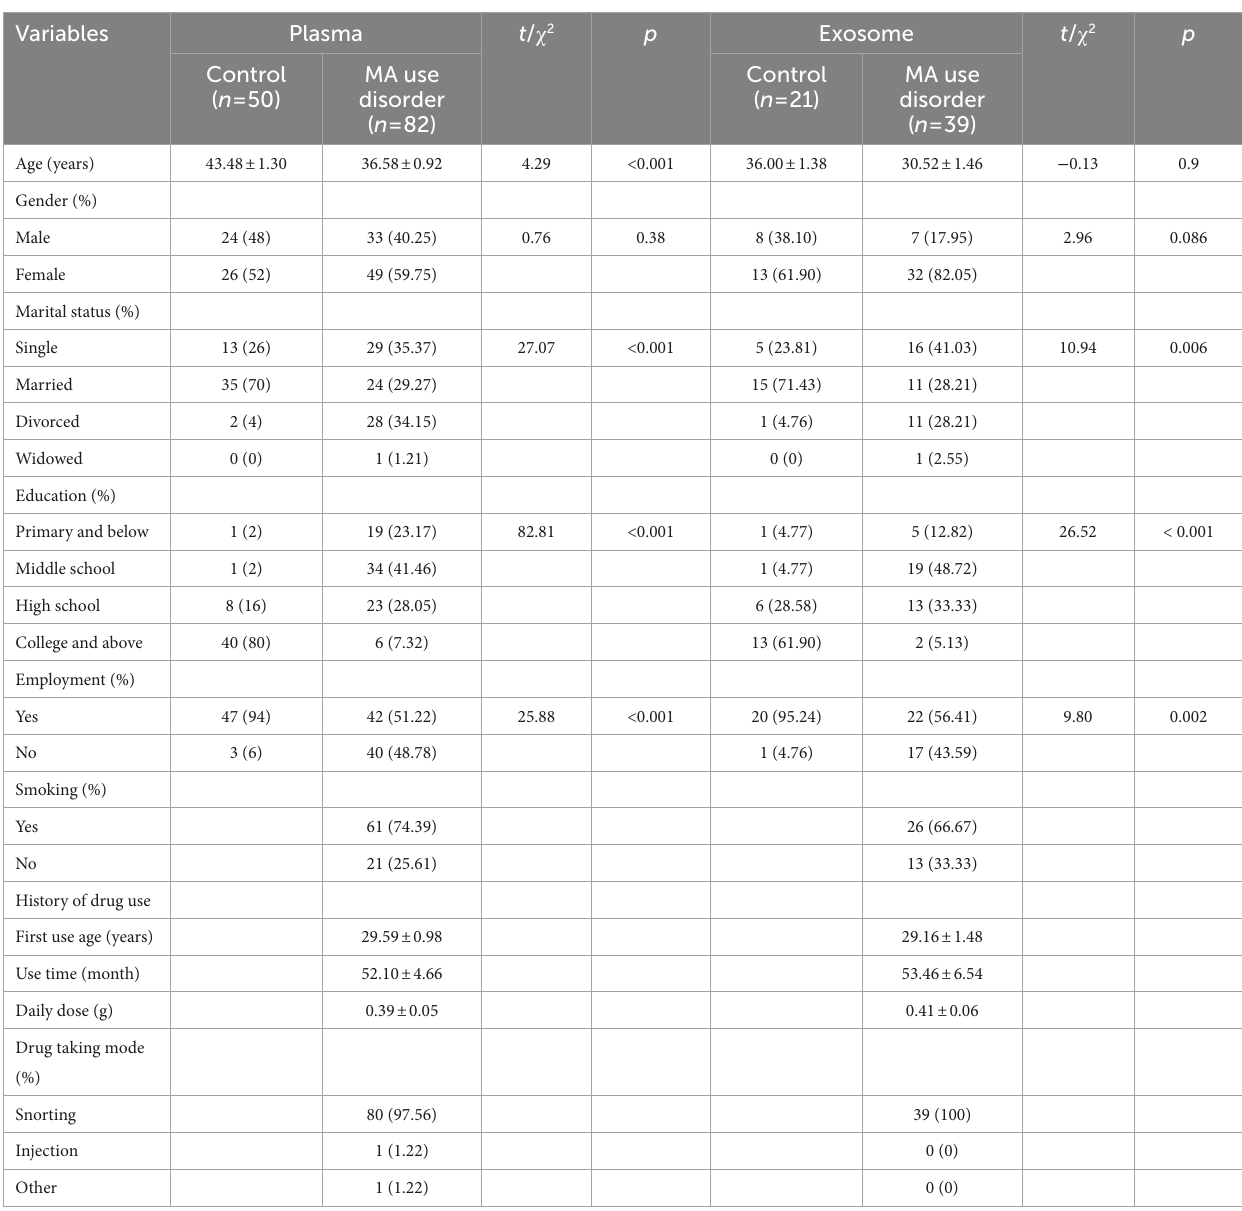
TABLE 2 Demographic characteristics of the participants.